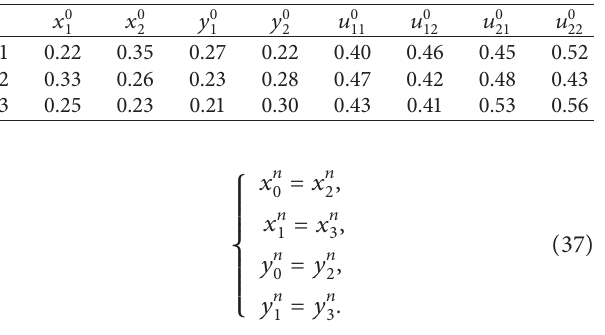
and u n for systems (36) 1 11